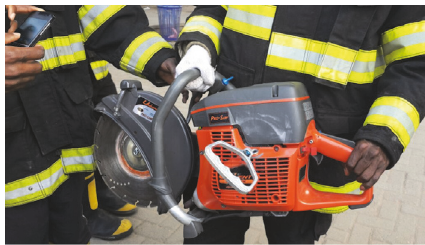
Figure 3: Power driven arc saw used by the men of the Lagos State Fire